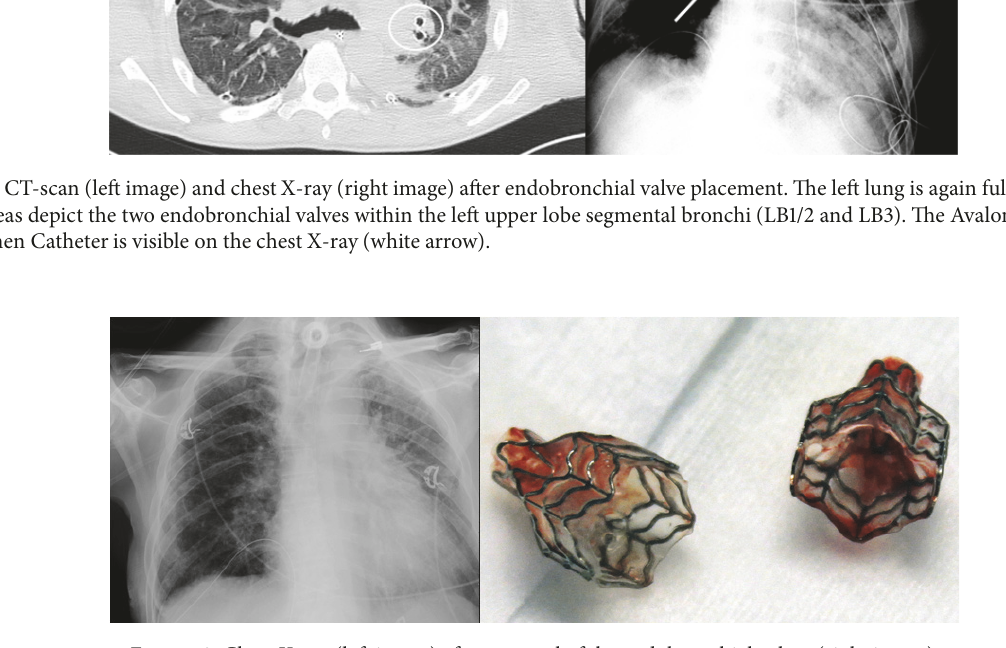
Figure 3: Chest X-ray (left image) after removal of the endobronchial valves (right